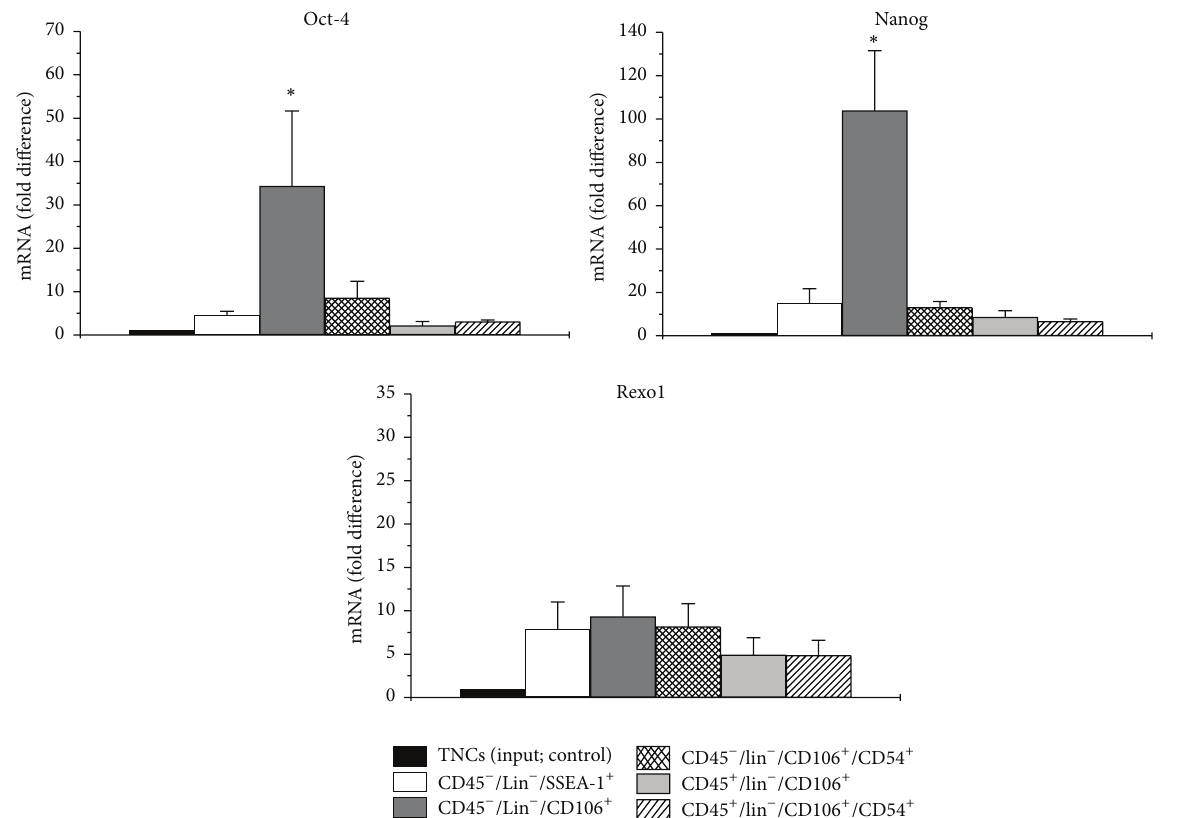
Figure 2: Expression of mRNA for Oct-4, Nanog, and Rexo-1 by real-time RT-PCR in sorted fractions of BM cells. Indicated populations of nonhematopoietic (CD45 − /Lin − /CD106 + , CD45 − /Lin − /CD106 + /CD54 + , and CD45 − /Lin − /SSEA-1 + ) and hematopoietic (CD45 + /Lin − /CD106 + ,CD45 + /Lin − /CD106 + /CD54 + )cells weresortedwithMoFlo XDP.Thegraphsshowthefolddifference inconcentration of mRNA for Oct-4, Nanog, and Rexo-1 in sorted fractions when compared to unfractionated TNCs (shown as 1). Results are presented as mean ± SD. Statistically significant differences ( 𝑃 < 0.05 ) are shown when compared with TNCs. Analysis was performed three times with samples prepared from three independent